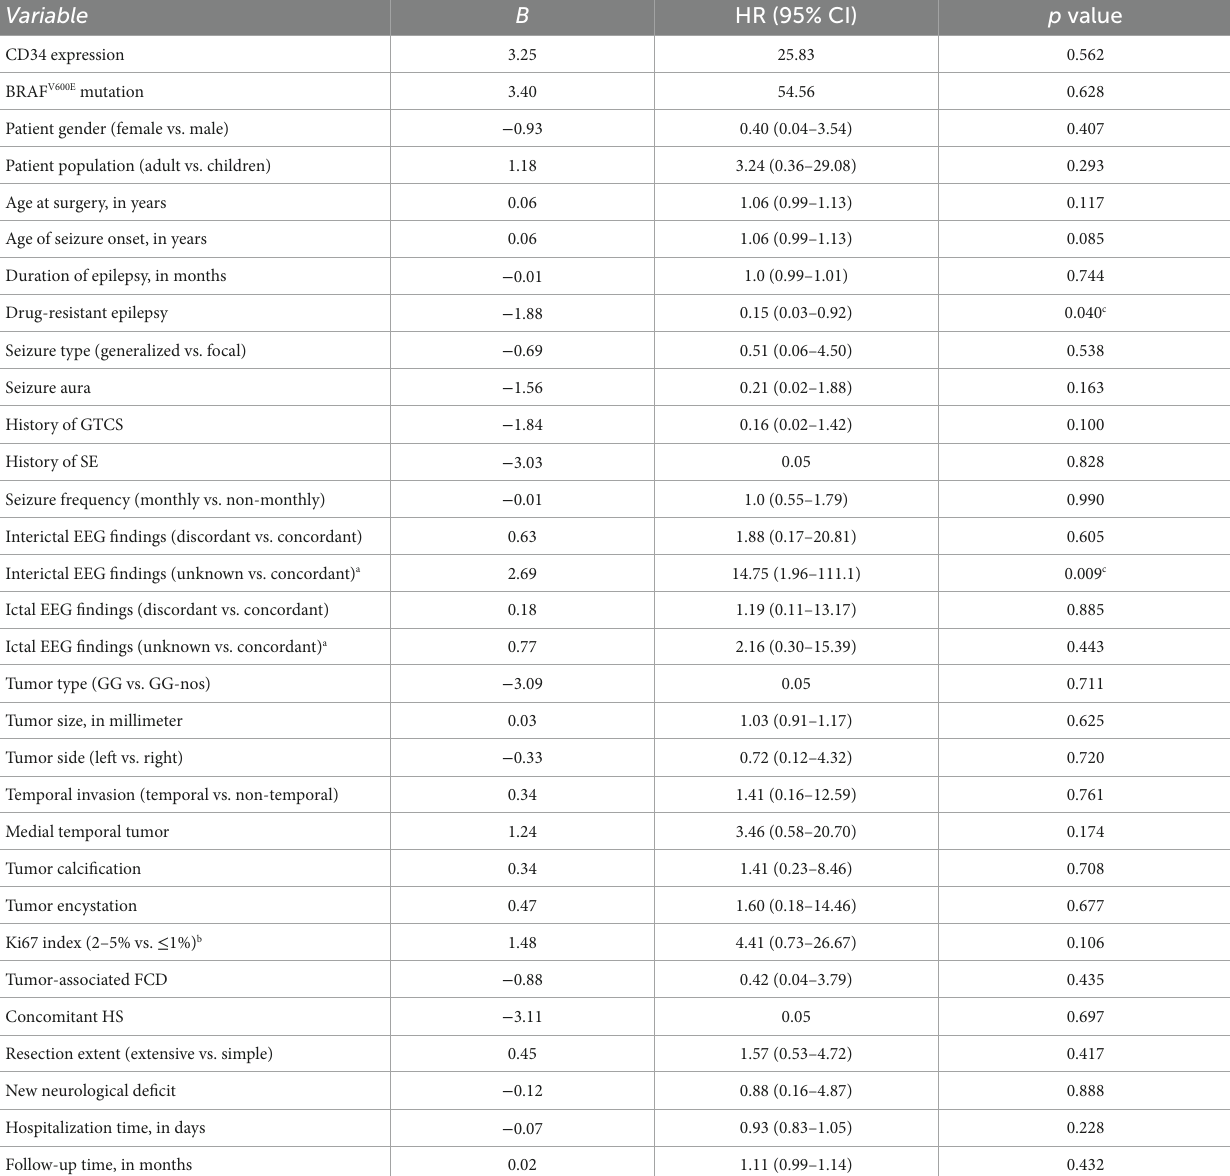
TABLE 4 Univariate cox regression analysis of the associations of clinical factors with tumor progression-free survival.